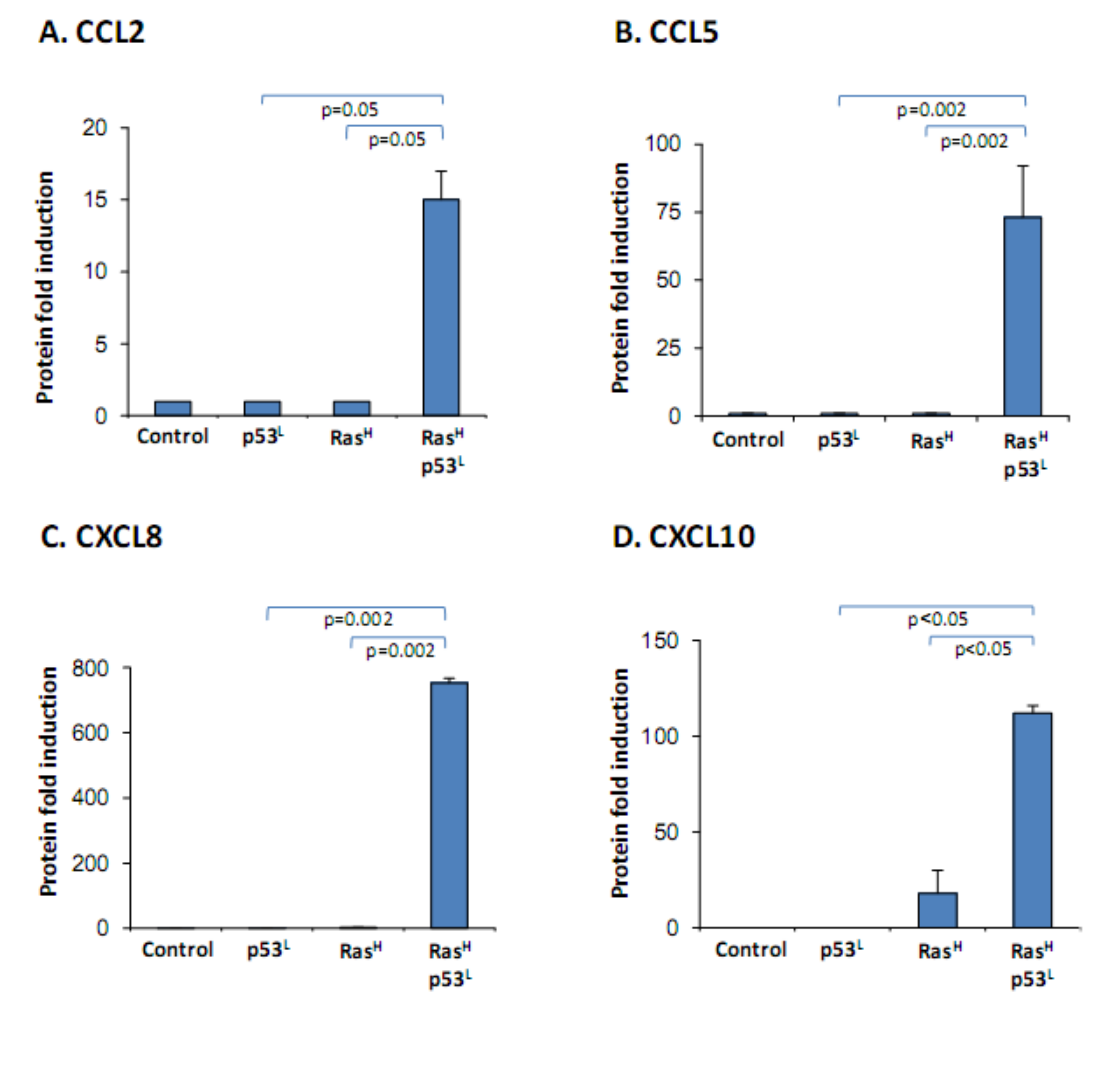
Figure 2. The release of the cancer-related chemokine cluster requires the synergistic activities of oncogenic Ras and dysfunctional p53. WI-38 human fibroblasts were modified to express oncogenic Ras and dysfunctional p53 together, or each alone. Chemokine expression was determined in supernatants of the different cell types by sandwich ELISA assays, at the linear range of absorbance. ( A ) CCL2. ( B ) CCL5. ( C ) CXCL8. ( D )